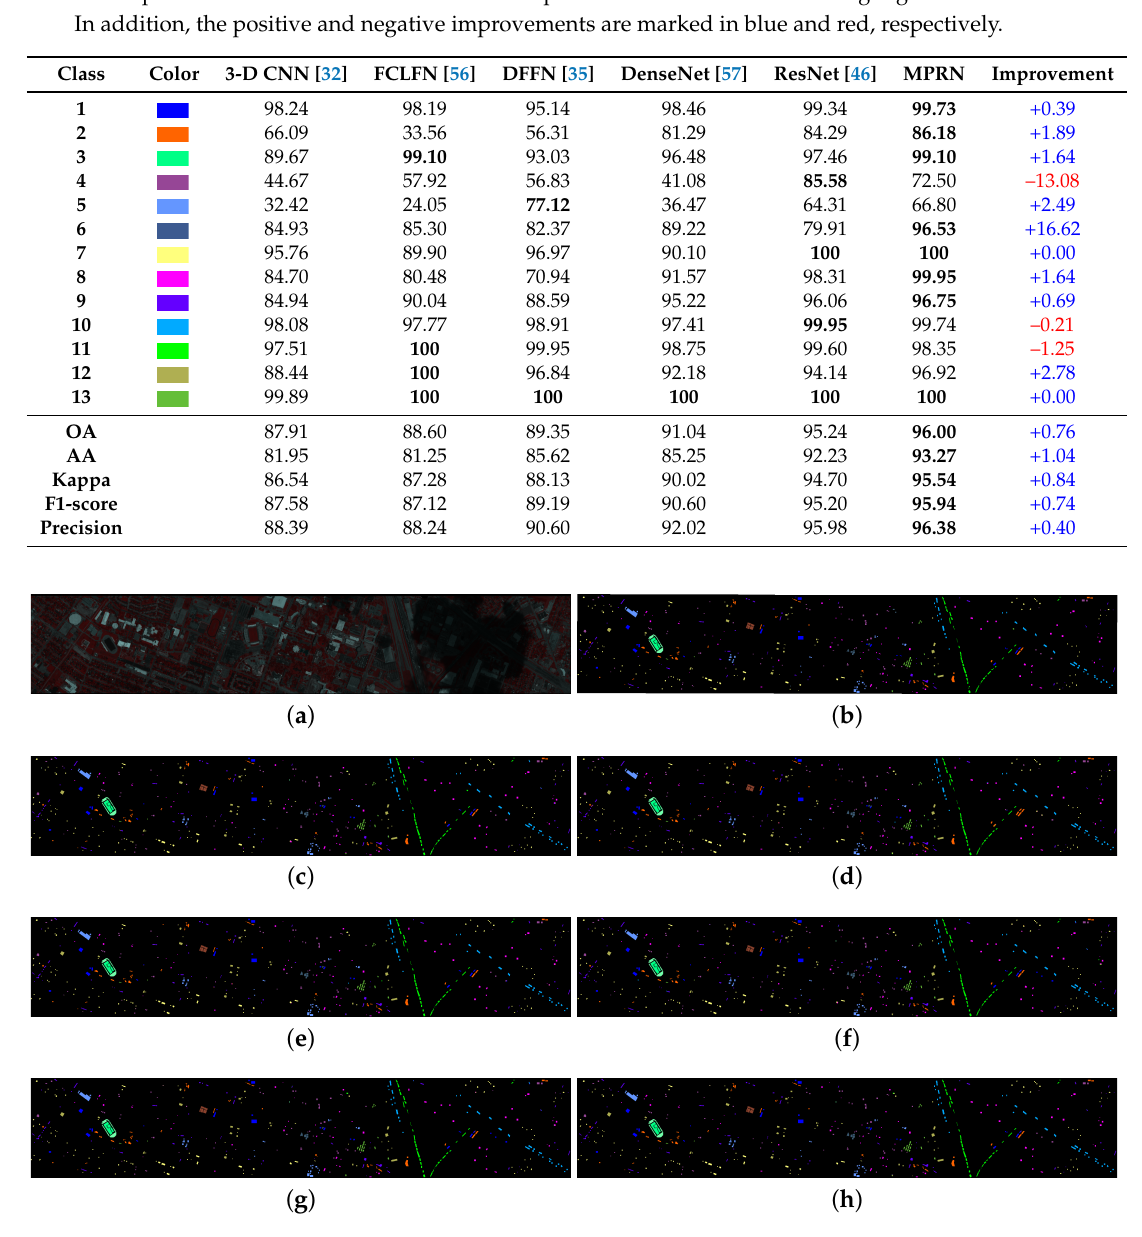
Figure 9. Houston University data set. ( a ) False-color composite image. ( b ) Ground reference map. The classification maps obtained by the ( c ) 3-D CNN (97.73), ( d ) FCLFN (96.81), ( e ) DFFN (97.44), ( f ) DenseNet (97.31), ( g ) ResNet (98.53) and ( h ) MPRN (98.88). Note that the overall classification accuracies (in %) are shown in